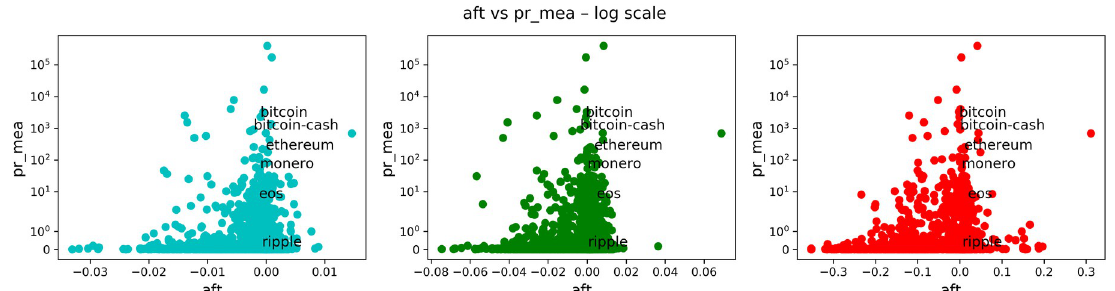
Fig 10. Comparison of anti-fragility values and pr_mea in cryptocurrencies. Each subplot corresponds to a timescale. The plots compare the corresponding A measure (x-axis) to the ‘good-performance’ measure pr_mea . We observe how higher values of the ‘good- performance’ measure concentrate in the robust axis A = 0 .